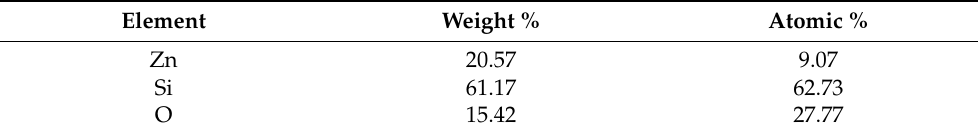
Table 1. Weight and atomic percentages of the SiO 2 -coated ZnO nanocrystals. Element Weight %